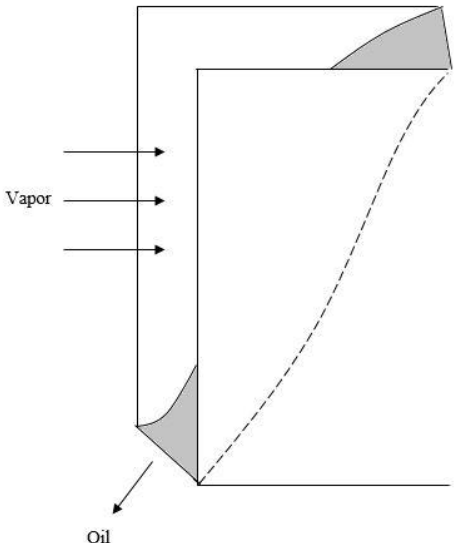
Figure 1—Schematic view of the recovery